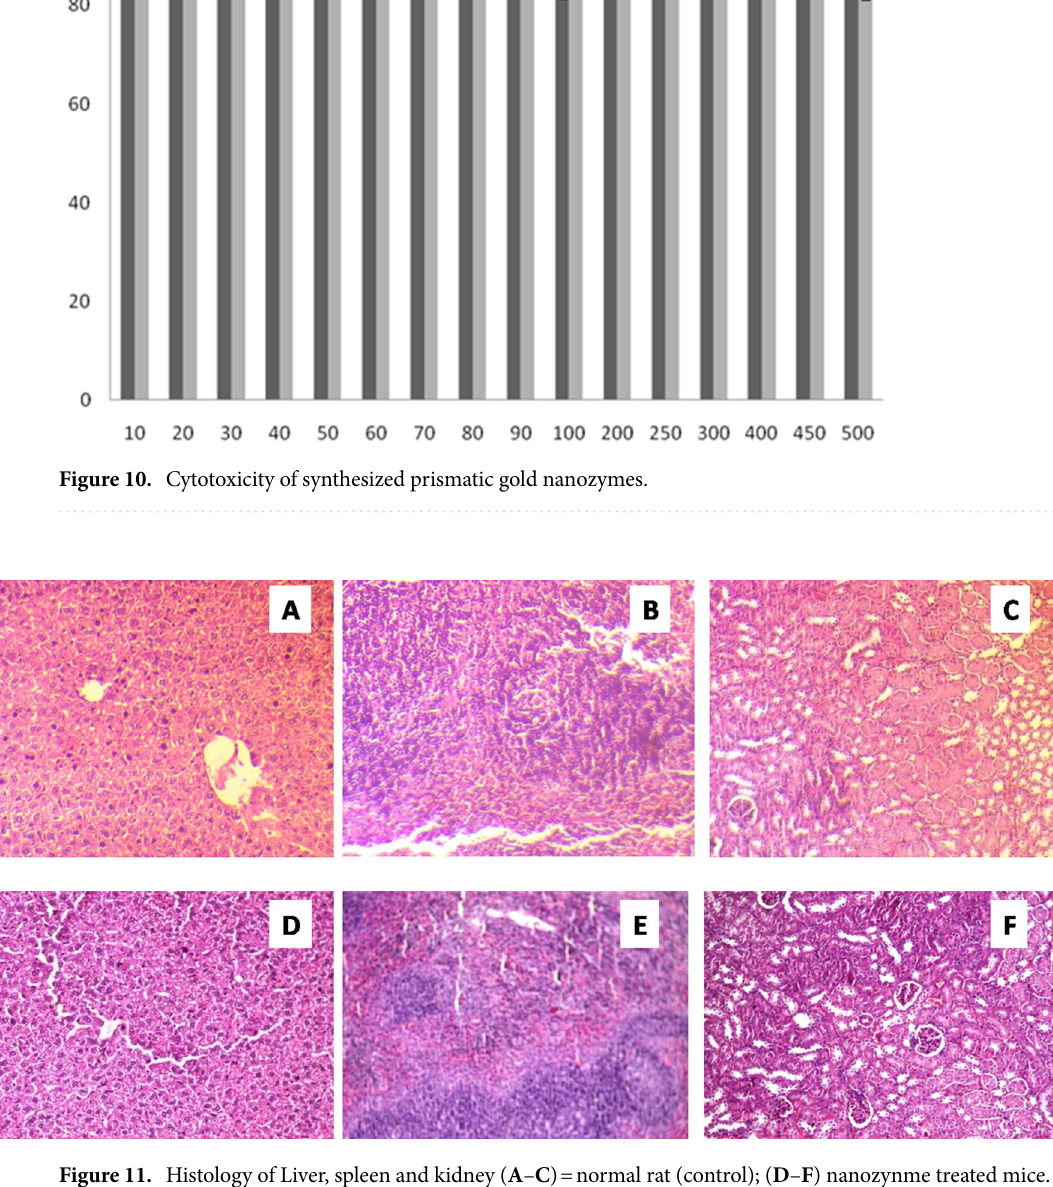
Figure 11. Histology of Liver, spleen and kidney ( A – C ) = normal rat (control); ( D – F ) nanozynme treated